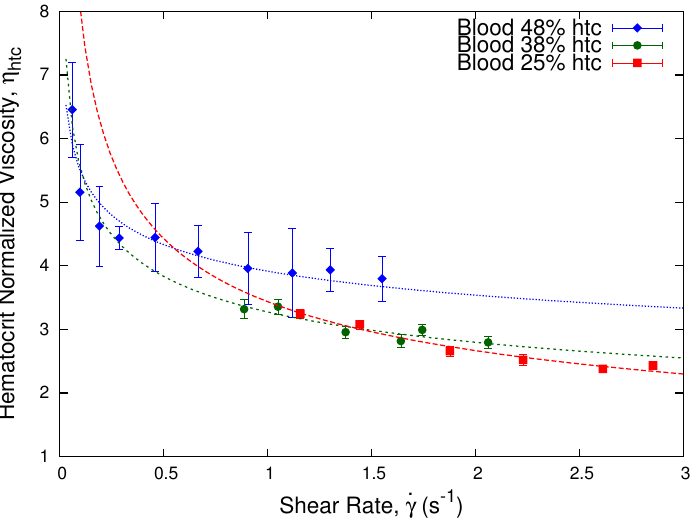
Figure 7. Hematocrit normalized viscosity vs. shear rate. Plot showing the hematocrit normalized viscosity, η htc , as a function of shear rate for blood samples from different donors: donor A with a 48% hematocrit, donor B with a 38% hematocrit, and donor C with a 25% hematocrit, according to Equation (15) as a function of φ control = 0.38.